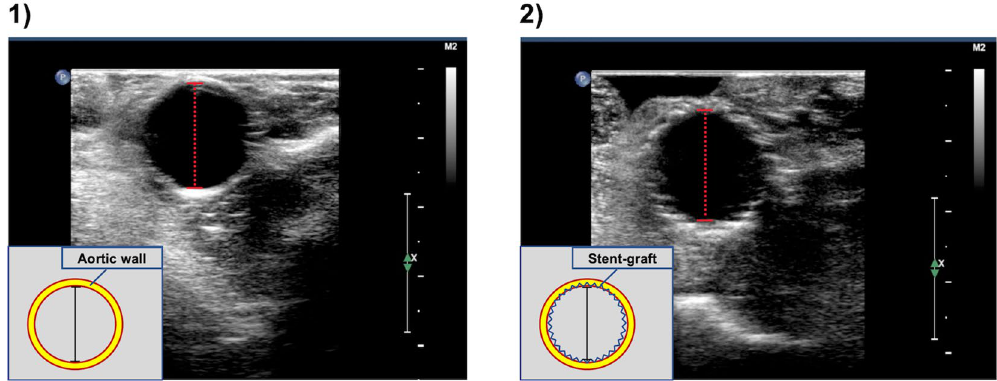
Figure 5. Ultrasound imaging of a cross section of the aorta at baseline ( 1 ) and after EVAR ( 2 ). The internal aortic diameters at the stent-graft site were measured as aortic diameter at baseline and after